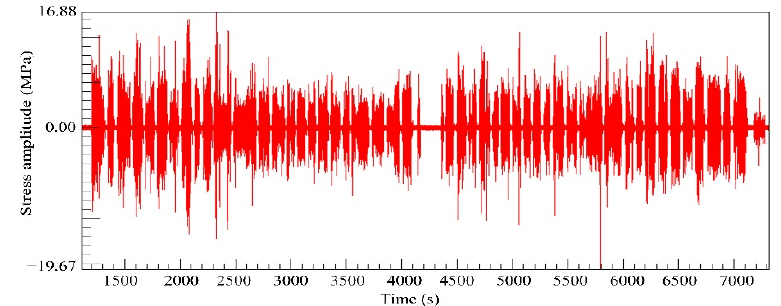
Figure 8. Stress–time history of a measuring point on outer variable section transition arc.